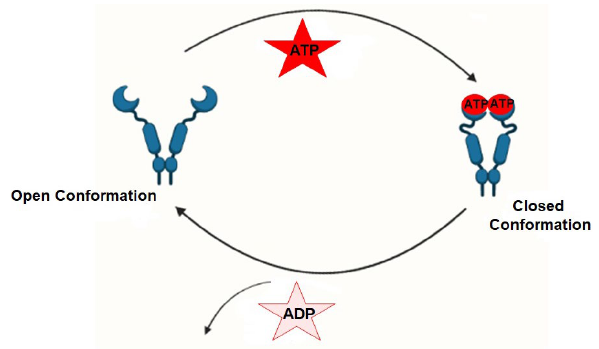
Figure 1. Representations depicting the conformational dynamics of Hsp90 (open and closed states) brought about by its ATPase function during substrate/client protein folding.